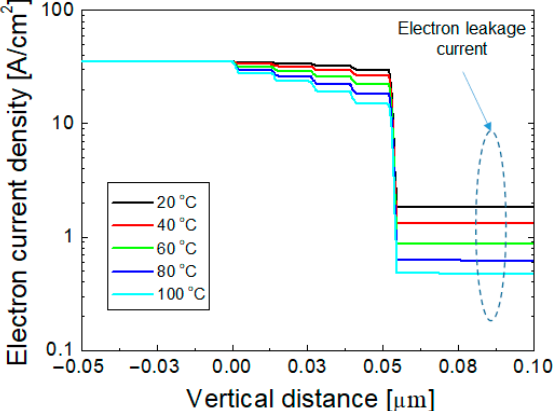
Figure 4. Simulated electron current density as a function of vertical position at 20, 40, 60, 80, and 100 °C when the injection current is 350 mA .